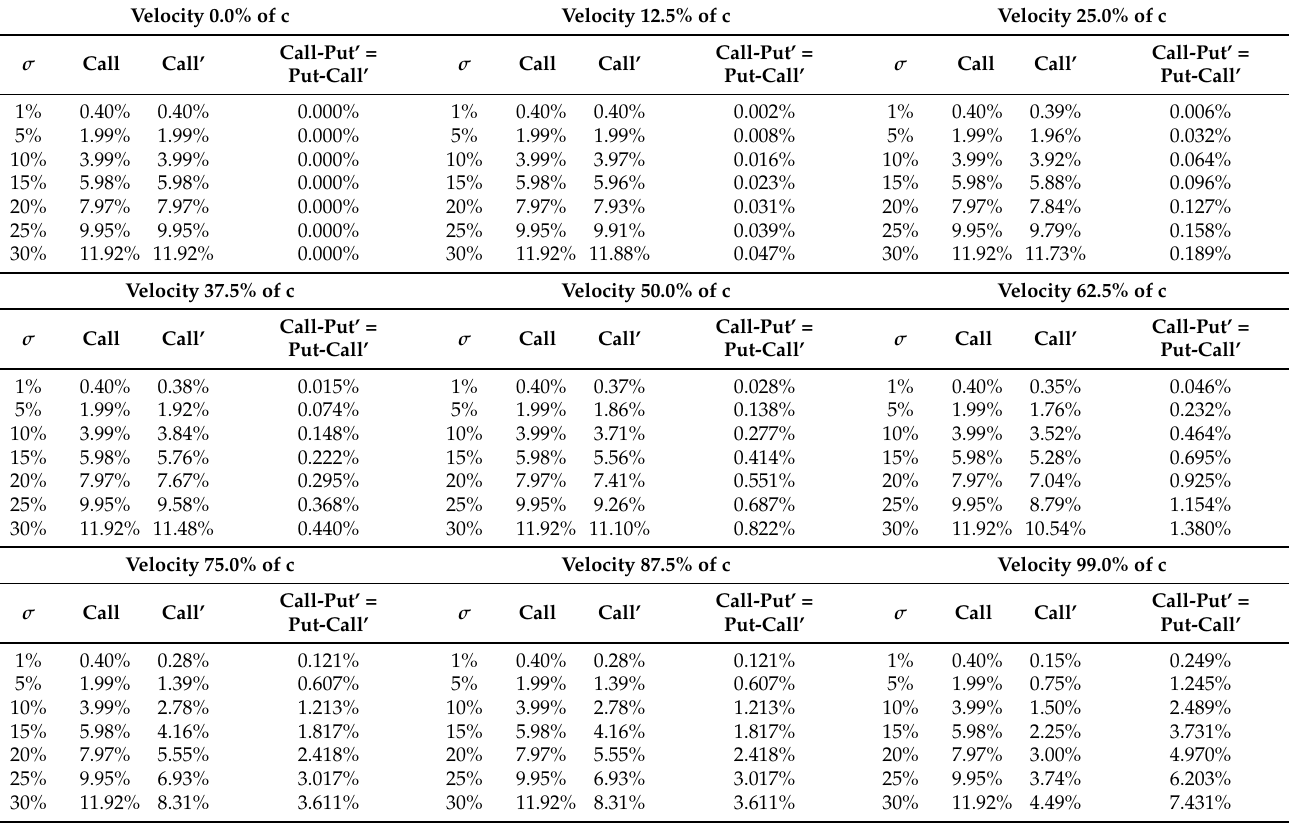
Table 5. Values for Call = Put , Call (cid:48) = Put (cid:48) and the difference Call − Put (cid:48) = Call (cid:48) − Put for T = 1, volatilities 1.0%, 5.0%, 10.0%, 15.0%, 20.0%, 25.0% and 30.0%, and for velocities 0.0%, 12.5%, 25.0%, 37.5%, 50.0%, 62.5%, 75.0%, 87.5% and 99.0% of c . For simplicity, we consider the values at inception t = 0, r = 0% and both asset prices at inception and strike equal to one S = K = 1. Lemma 2 and Proposition 1 prove, respectively, that Call = Put and Call (cid:48) = Put (cid:48)